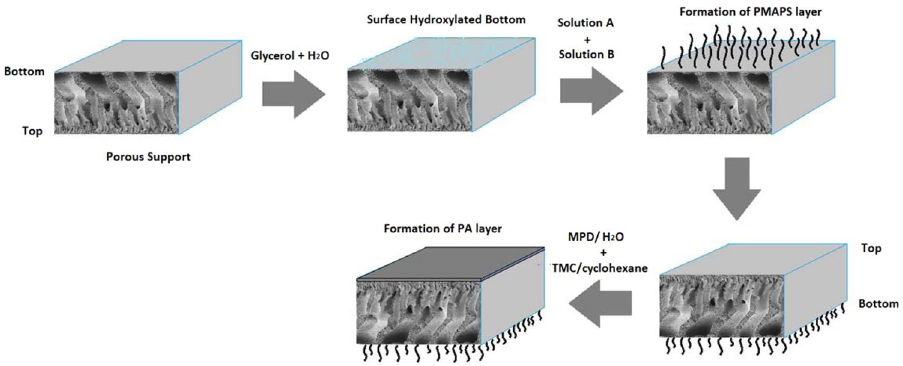
Figure 1. The fabrication procedure of double-skinned TFC